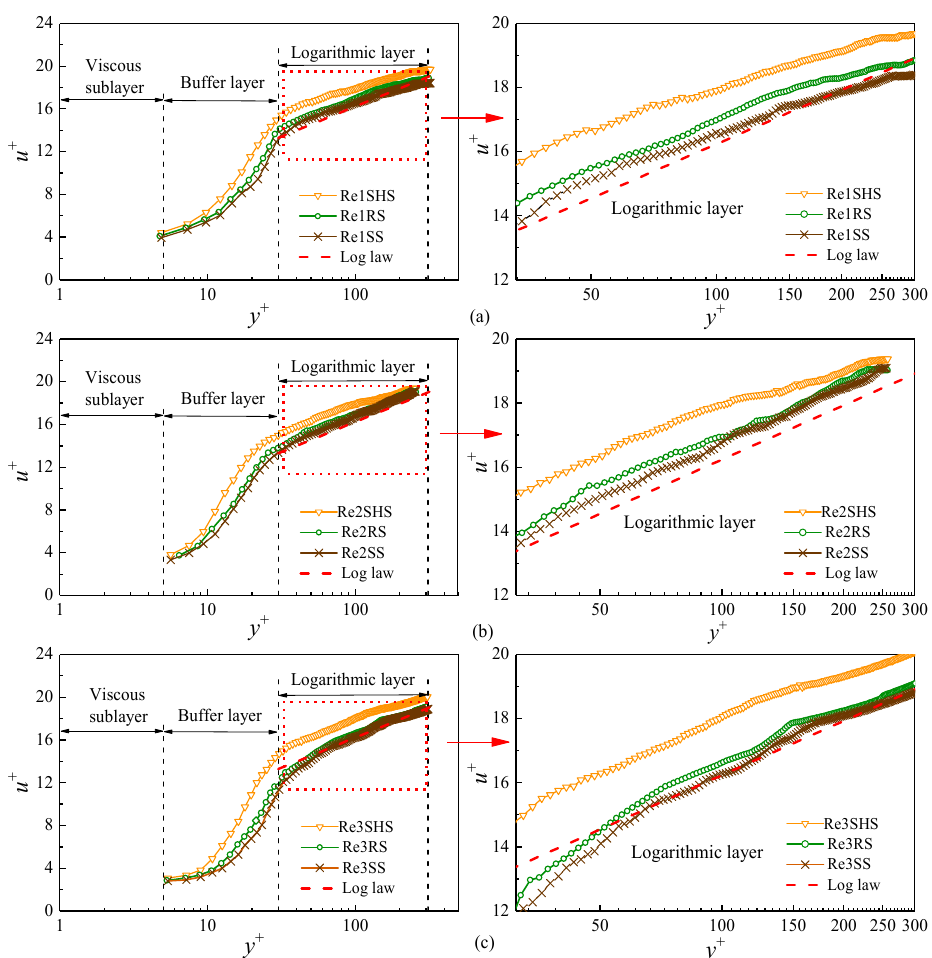
Figure 4. Dimensionless velocity u + of microstructured surfaces along the normal distance y + . ( a ) The velocity distribution of Re1. ( b )The velocity distribution of Re2. ( c ) The velocity distribution of